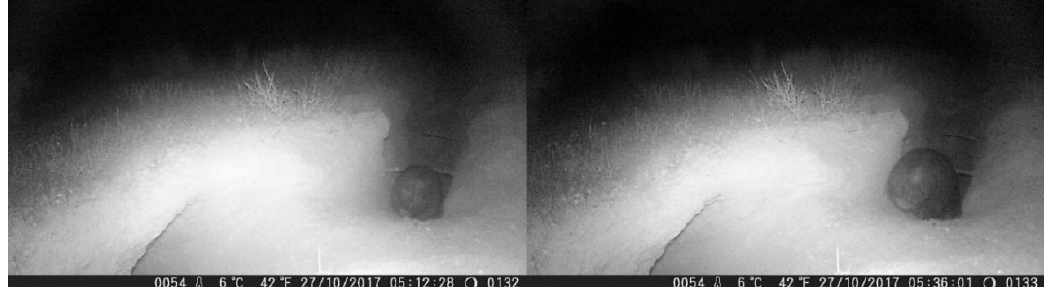
Figure 4. Video captures from the close-up video camera at Moorunde site #4 showing an example of simultaneous burrow sharing by two wombats. In the left image (captured from video # 0132), a wombat enters the burrow at 05:12. Twenty-four minutes later at 05:36, recorded on the subsequent video (# 0133), a second wombat enters the same burrow.